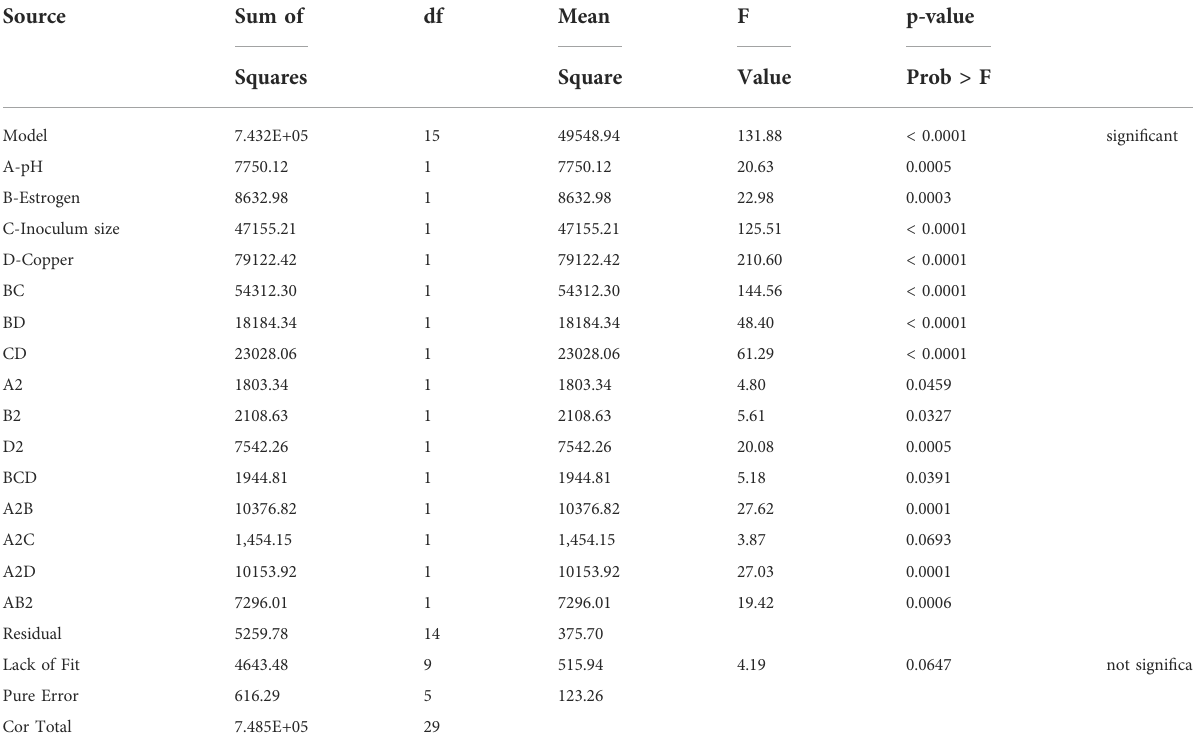
TABLE 4 Reduced cubic ANOVA model for Lysinibacillus. BP1 (B) laccase